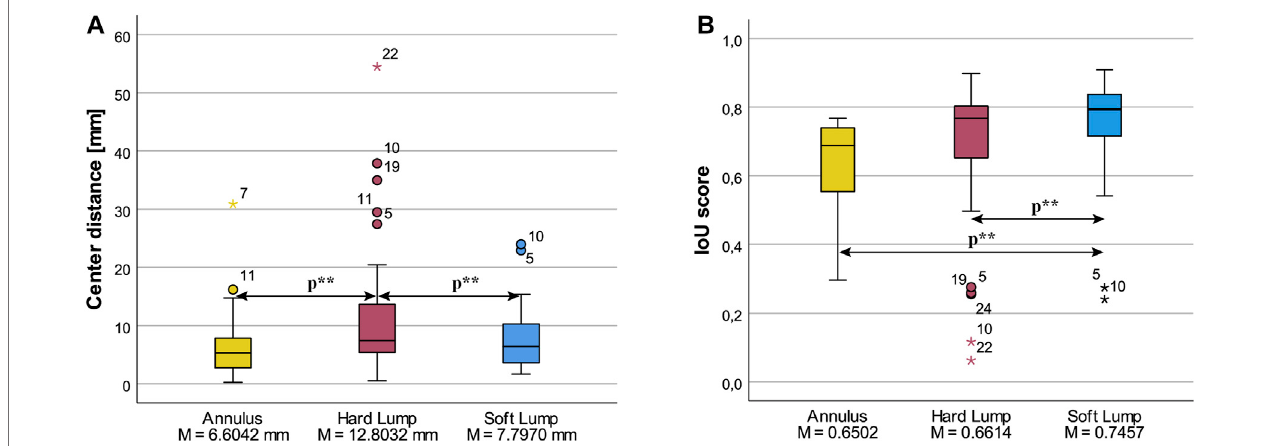
FIGURE 11 | Box plots of (A) Center distance of granulate and drawing, and (B) Intersection over Union, for the three lump conditions. Statistically signi fi cant differences at p < 0.05 are indicated by p **.